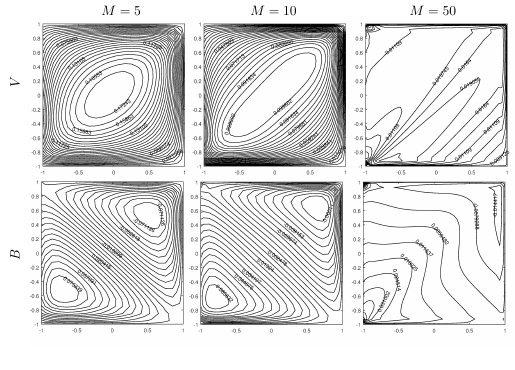
Figure 10. Velocity and induced magnetic field from inverse solution, π β = 3